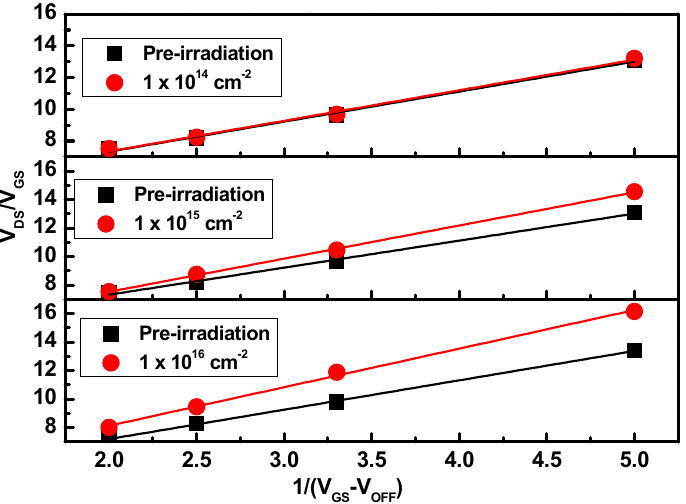
Figure 5. The variation V DS /I DS as a function of 1/(V GS -V OFF ) for different electron fluences.